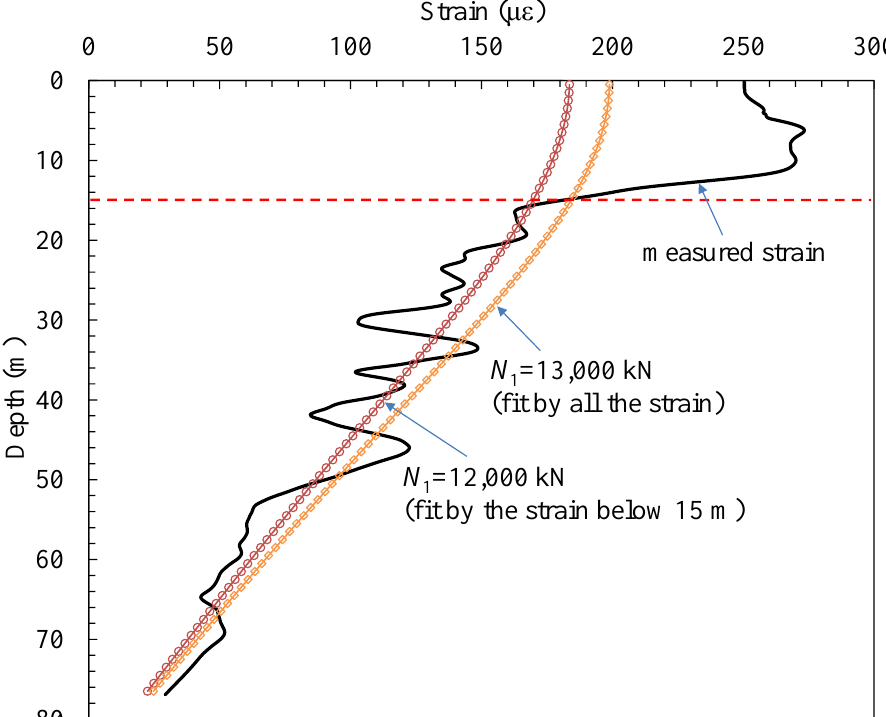
Figure 11. Effect of the friction angle at the interface of soil and pile.